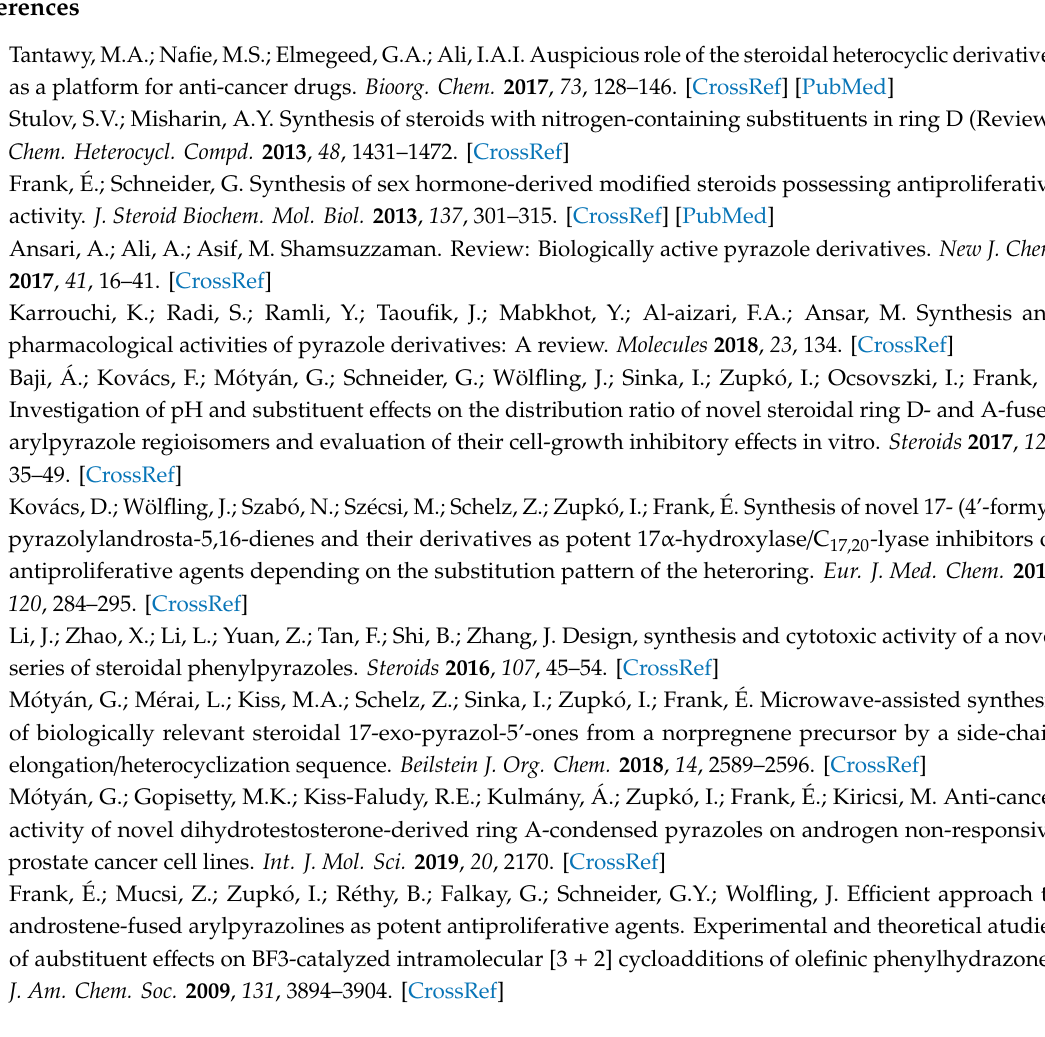
H NMR and 13 C NMR spectra of the synthesized compounds, Table S1: Mean ± SD values of primary growth inhibitory screen (given as cell viability) used for heat map construction, Figure S1: Representative cell viability curves to determine growth inhibition and IC 50 values following treatments with (a) compounds 6g or (b) cisplatin on di ff erent cell